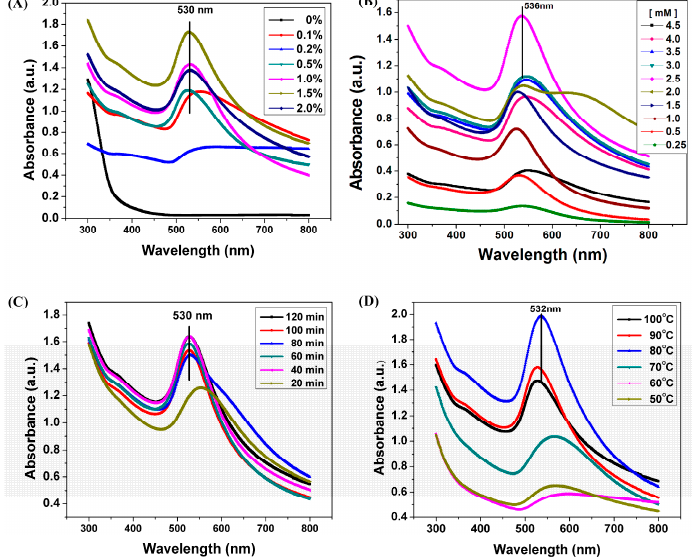
Figure 1. Effect of reaction parameters on the synthesis of gold nanoparticles. ( A ) UV-vis spectra of AuNPs prepared using different concentrations of sodium alginate in the presence of HAuCl 4 (2.5 mM) at 90 °C for 60 min; ( B ) UV-vis spectra of AuNPs prepared using different concentrations of HAuCl 4 , sodium alginate (1.0%) at 90 °C for 60 min; ( C ) UV-vis spectra of AuNPs prepared at different reaction time with sodium alginate 1.0%, HAuCl 4 1.2 mM at 90 °C; ( D ) UV-vis spectra of AuNPs prepared with different reaction temperature with sodium alginate 1.0%, HAuCl 4 1.2 mM, 60 min.